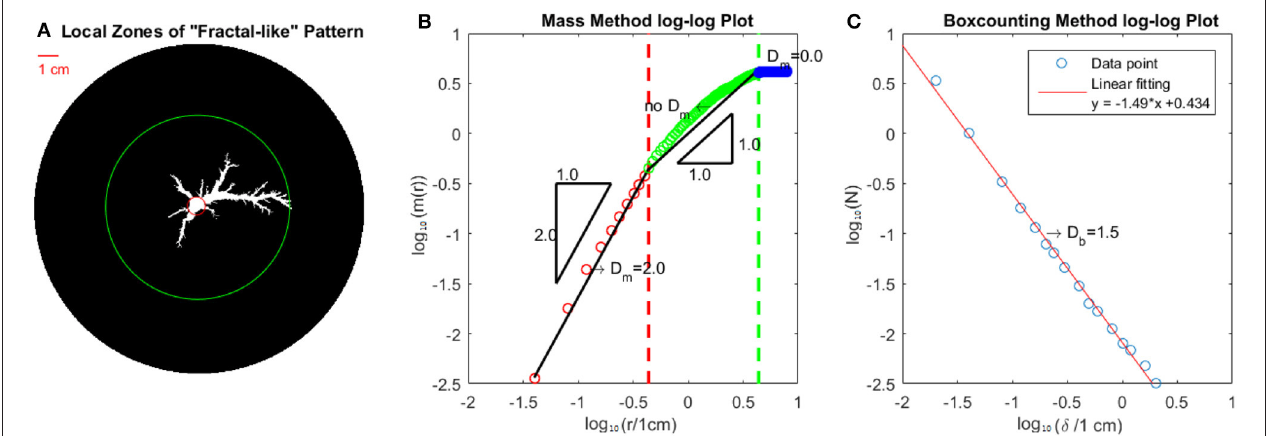
FIGURE 2 | Measurement of fractal dimension from experimentally derived images. (A,B) Show the mass fractal dimension estimation method. In (A) , we divide the pattern into 3 zones. The part within the red circle is completely dissolved. Between the red and green circles, “fractal-like” fingers expand in different directions. Outside of the green circle lies an entirely undissolved zone. (B) Shows a log-log plot of mass m ( r ) vs. radius r , with the colors corresponding to the relevant zones in (A) . The black linear solid lines act as a guide for the eye. The slopes of the black lines are illustrated with the triangles. For the red and blue parts, the fractal dimension by mass method D m is indicated. For the green part, there is no clear linear part, i.e., no well defined mass fractal dimension D m . In (C) we use the Box-counting Method to obtain the box-counting fractal dimension D b 1.5. =